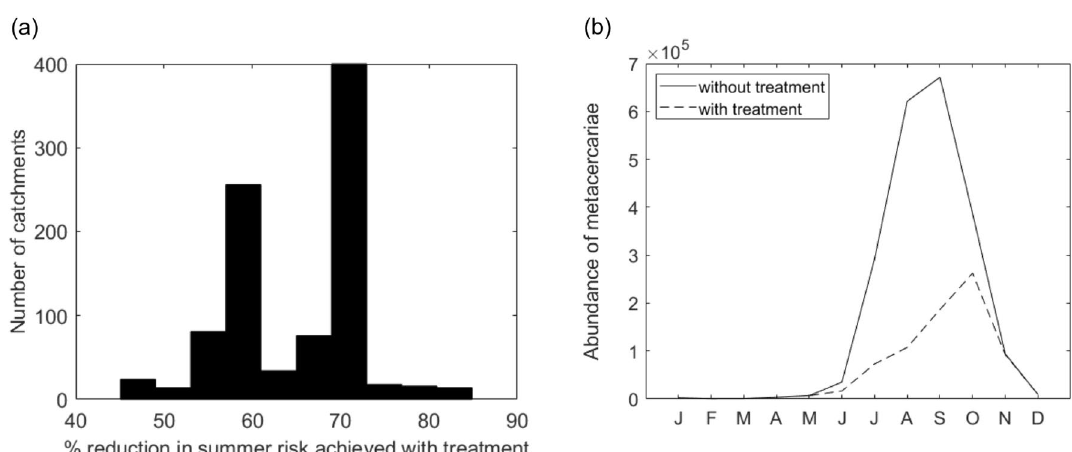
Figure 3. Effect of treating livestock twice per year (in January and April) using the current most efficient antiparasitic drug (90%) and assuming no resistance, on: ( a ) summer disease risk across all 935 analyzed catchments; ( b ) the monthly abundance of infective metacercariae on pasture (i.e. disease risk), on average across all catchments and